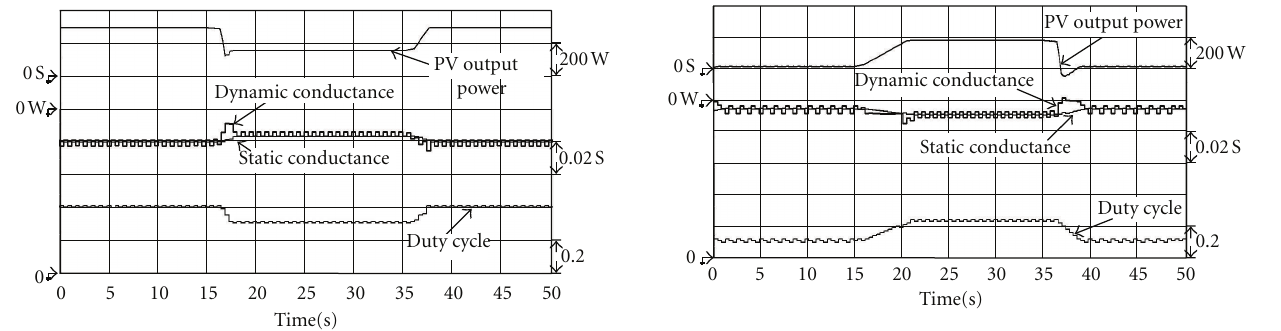
Figure 13: Simulated output power, dynamic conductance, static conductance, and duty cycle waveforms of a PV module array using the variable step size INC method under irradiation that increased from 450W/m 2 to 750 W/m 2 and then dropped back to 450W/m 2